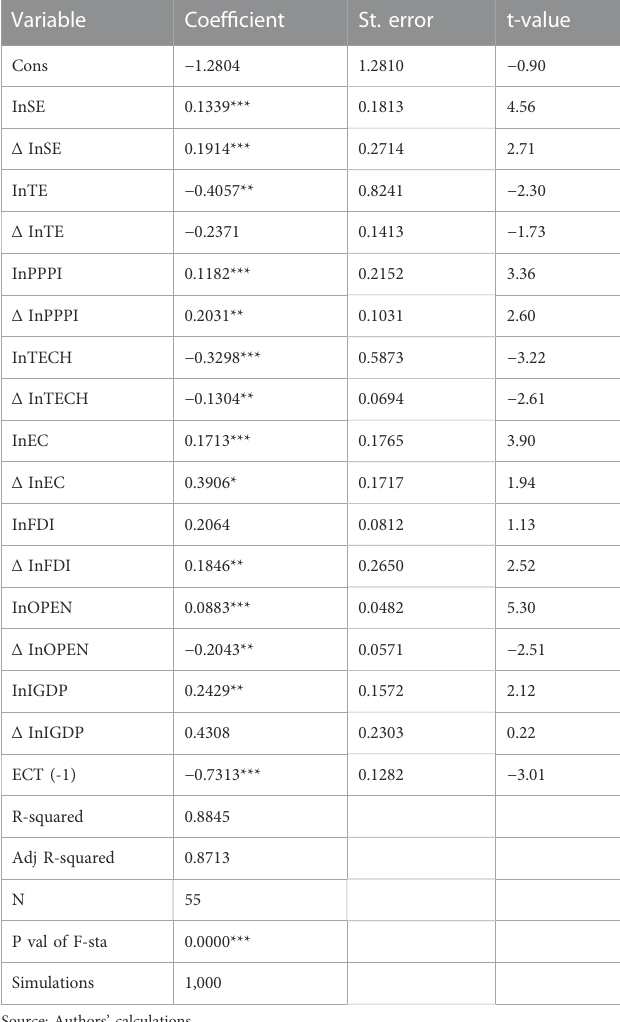
TABLE 8 Dynamic ARDL simulations